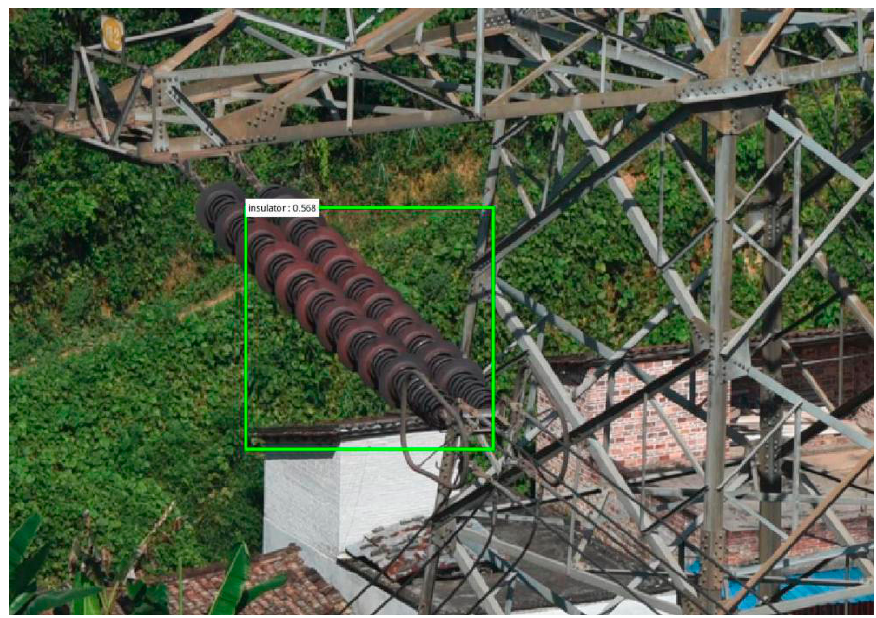
Figure 3. Result of removing redundant boxes by original non-maximum suppression (NMS).